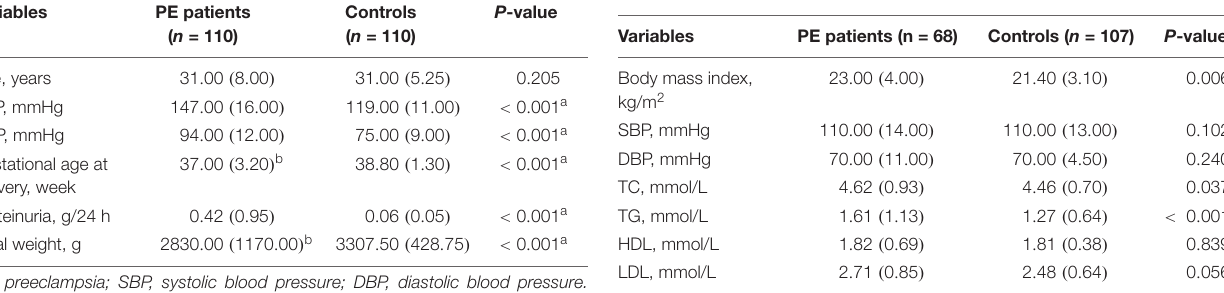
TABLE 1 | Clinical characteristics of participants at diagnosis. TABLE 2 | Clinical characteristics of participants in early pregnancy (12–14 gestational